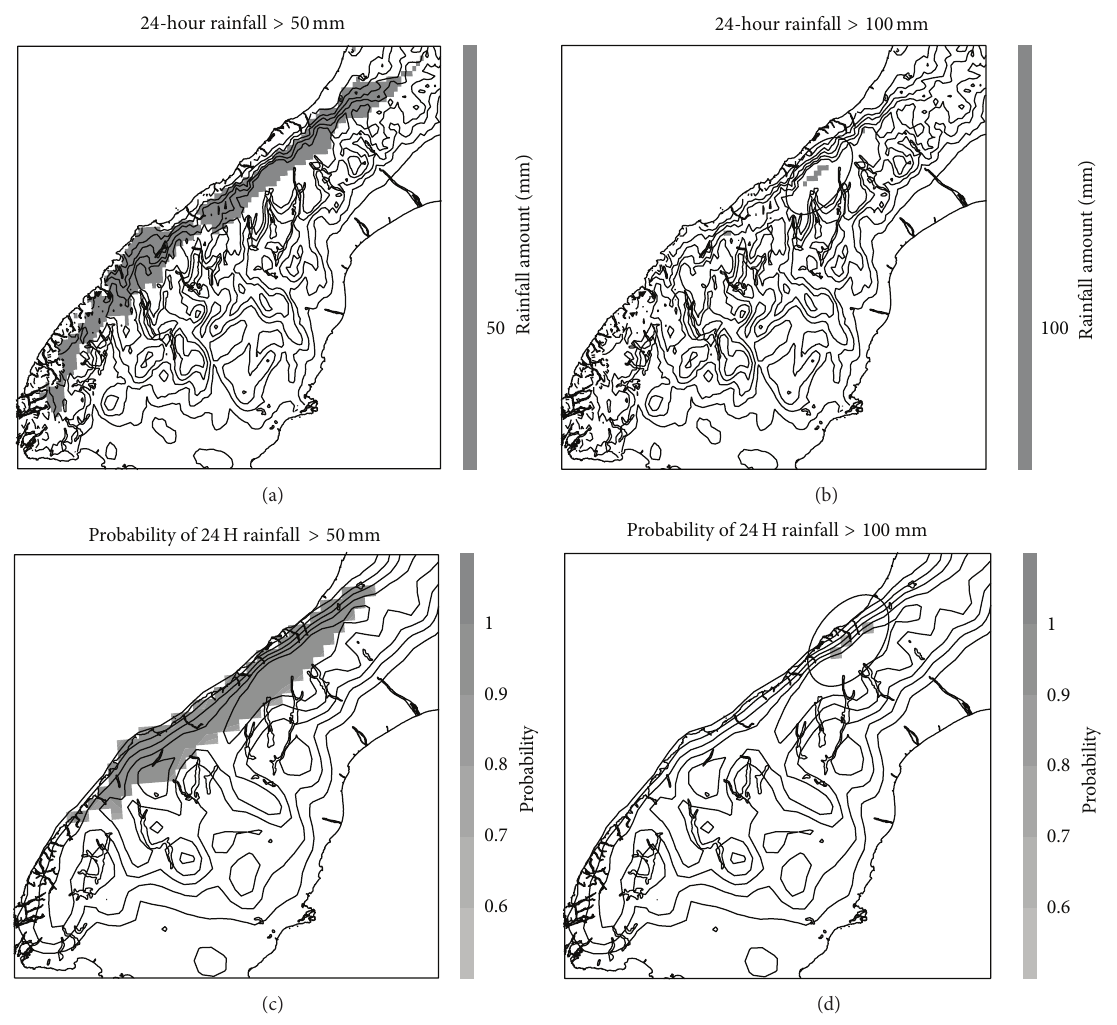
Figure 5: Same as Figure 3 but for 24-hour rainfall valid at 0900 NZST 29 September. Some shading areas in the circle of (b) had 24-hour rainfall greater than 100mm and in the circle of (d) had occurrence probability higher than 0.6 for 24-hour rainfall greater than 100mm.